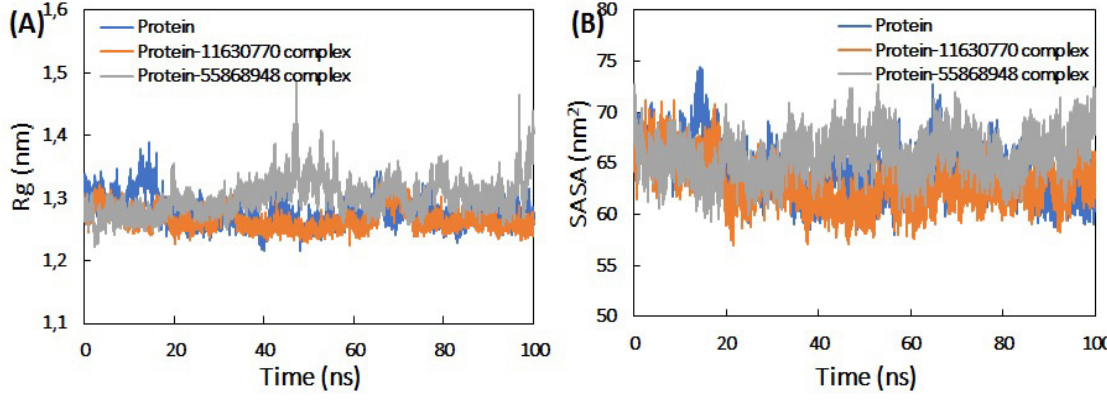
Fig. 9 . (A) Radius of gyration (R g ) of 5v4y HIV-1 protease in the absence and presence of CID 11630770 and CID 55868948 as a function of simu- lation time. (B) Solvent accessible surface area (SASA) of HIV-1 protease in the absence and presence of CID 11630770 and CID 55868948 as a function of simulation